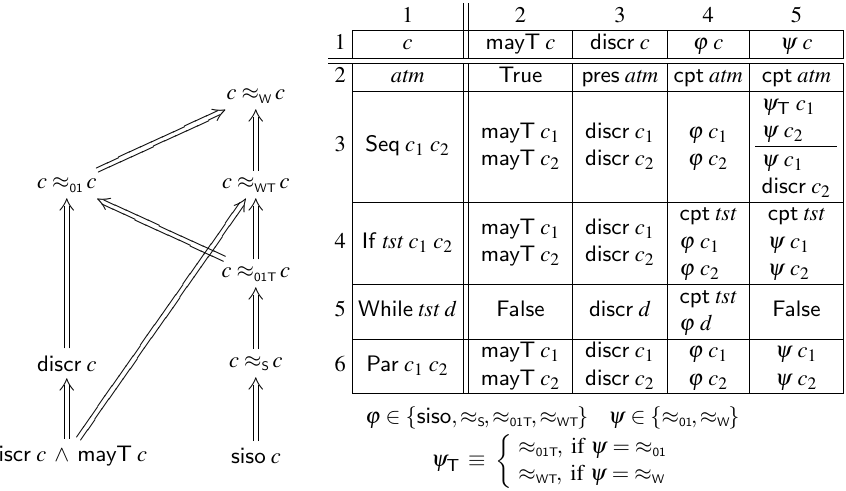
Figure 3: Implications between security notions Figure 4: Compositionality